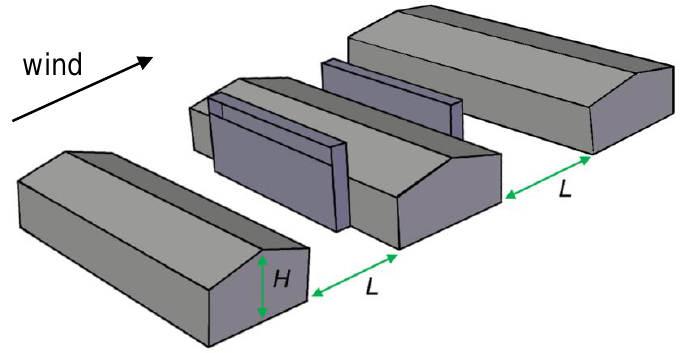
Figure 6. Distance between the greenhouse with a passive downdraught evaporative cooling windcatcher (PDEC-WC) and neighbouring structures. Table 1. Simulated configurations of the greenhouse with neighbouring structures.